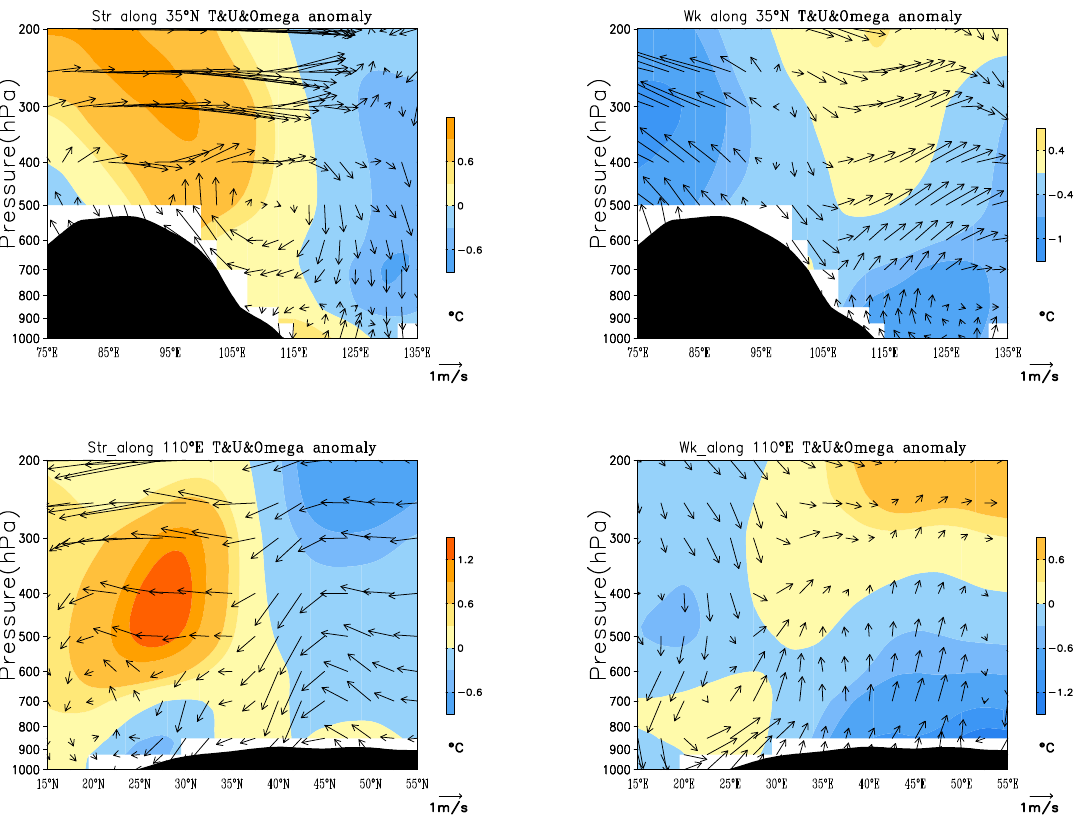
Figure 7. Circulation and temperature fields in the east-west ( top ) and north-south ( bottom ) cross-sections of the Fen-Wei Plain region in strong ( left ) and weak ( right ) cold source years of the Qinghai-Tibet plateau.